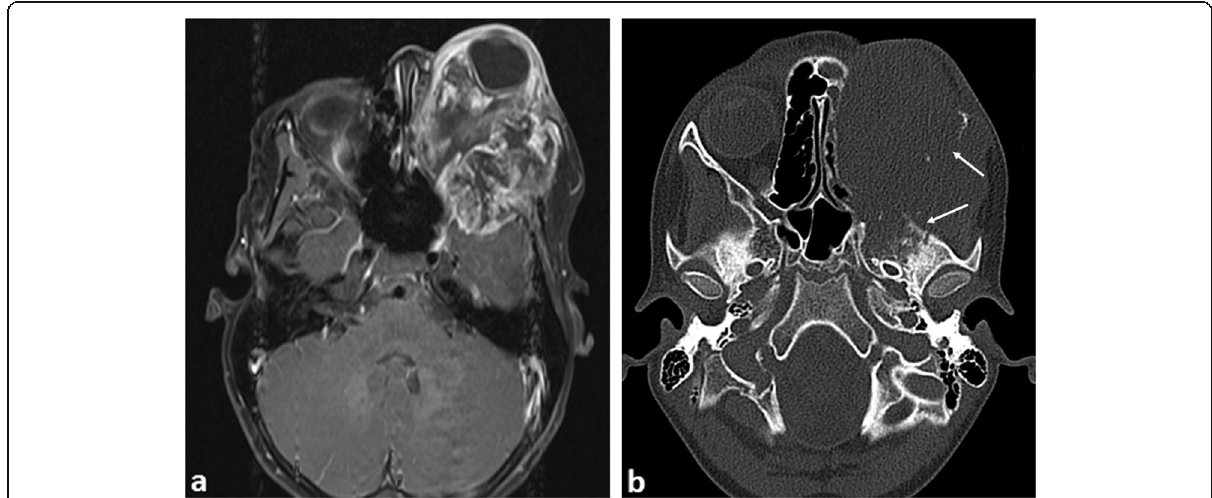
Fig. 4 A 9-year-old boy with proptosis due to a left orbital rhabdomyosarcoma. a Axial post-contrast-enhanced T1-weighted MR image shows a large periorbital soft tissue mass with marked internal heterogenous enhancement invading the temporal fossa. b Axial CT image of the orbit demonstrates marked bony destruction of the skull and left ethmoid sinuses